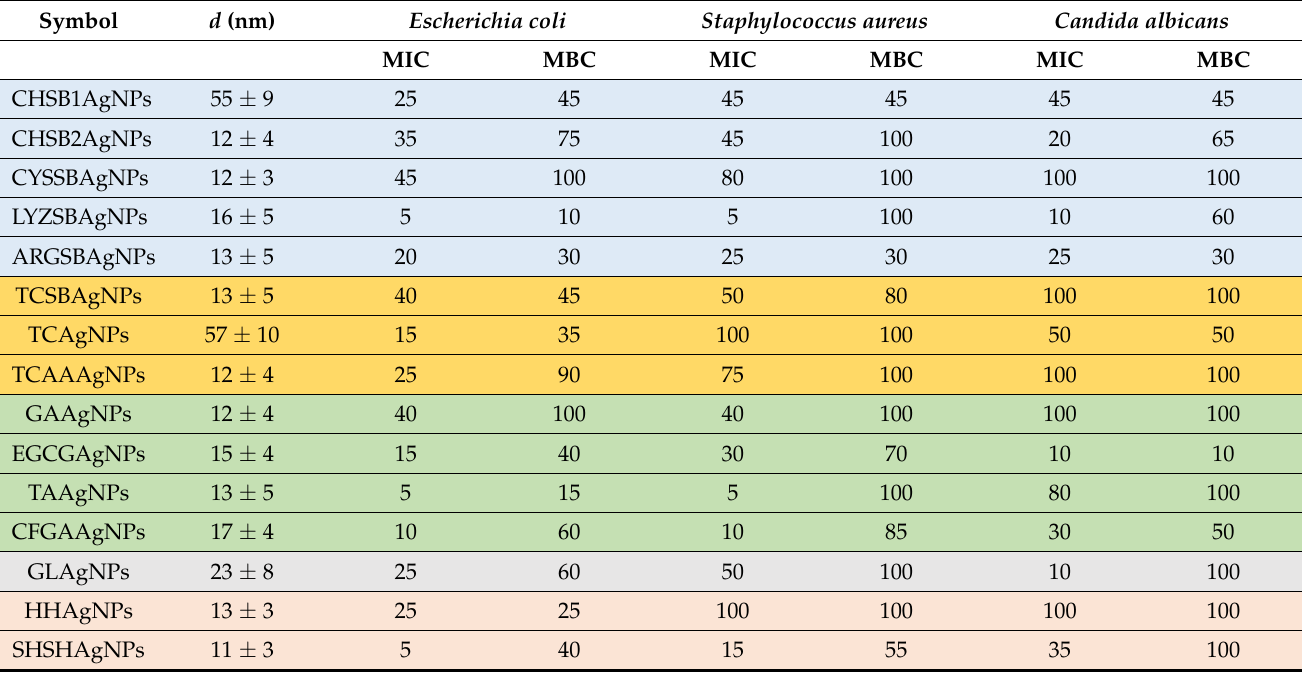
Table 3. Biocidal properties of AgNPs expressed as the AgNP concentration established as minimum inhibitory concentra- tion (MIC) and minimum bactericidal concentration (MBC) for a given type of AgNP and determined for E. coli (ATCC 25922), S. aureus (ATCC 292113), and C. albicans (ATCC